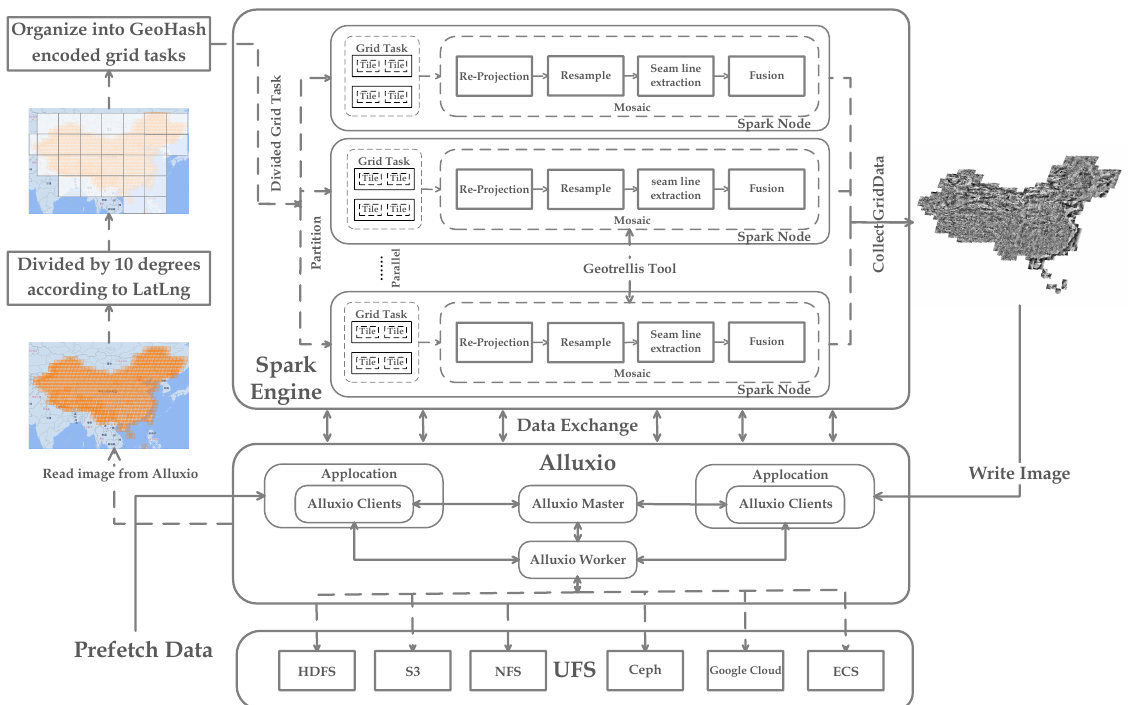
Figure 2. Spark first reads the image data from alluxio, collects the spatial range information of the tile data, establishes a geographic grid, and uses the Hadoop API of Spark and geogrillis to convert the remote sensing image into RDD. Then, it preprocesses each RDD for a remote sensing image, performs mosaic calculation, and finally writes it to alluxio to complete the image mosaic